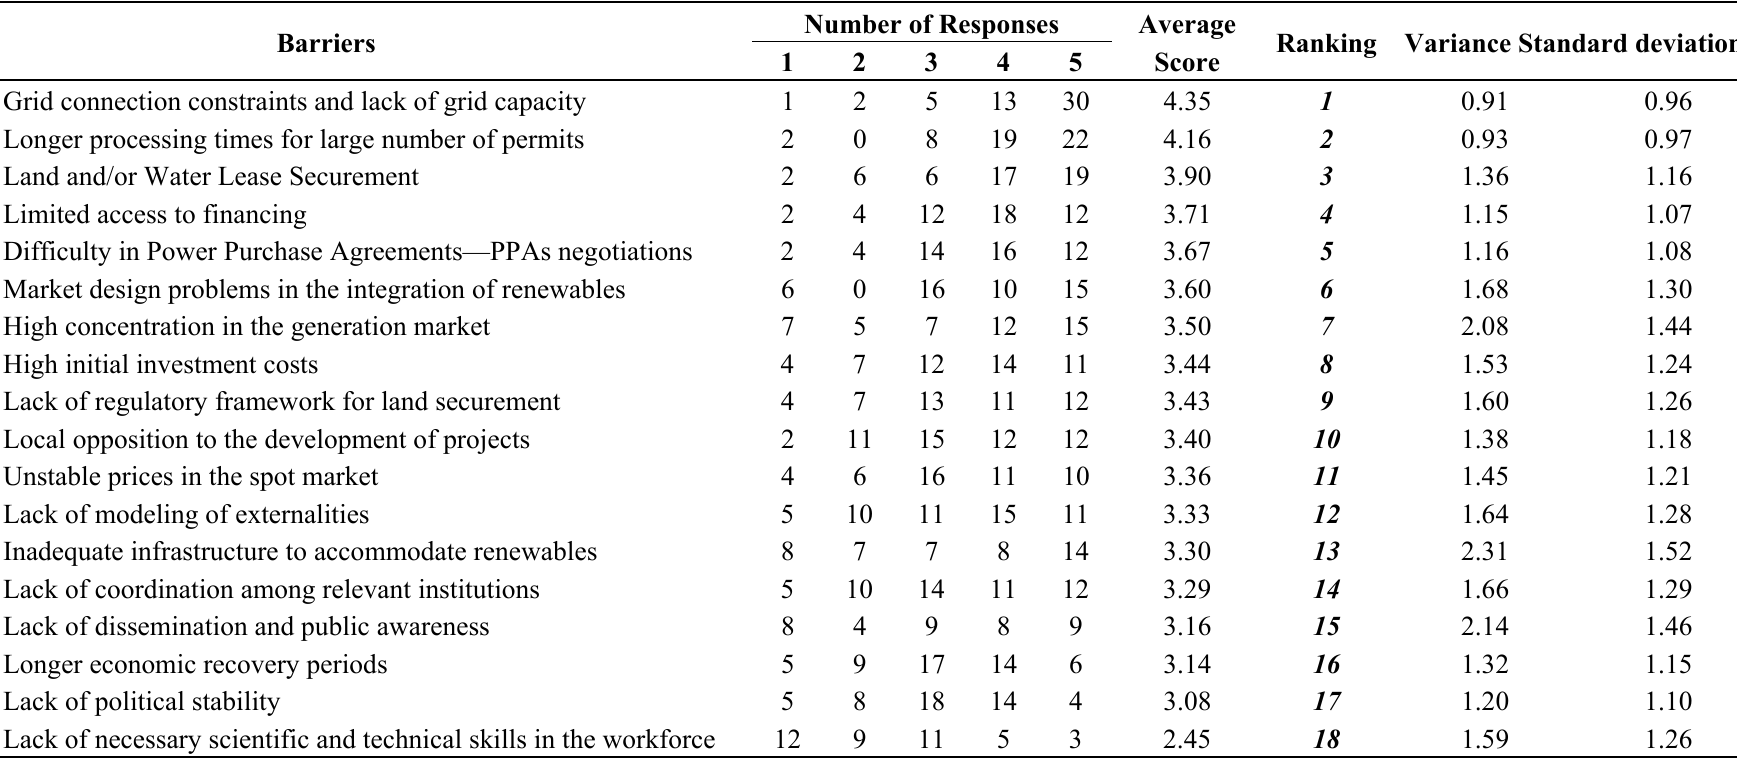
Table 4. Mean scores variance and standard deviation of the barriers in the RES in